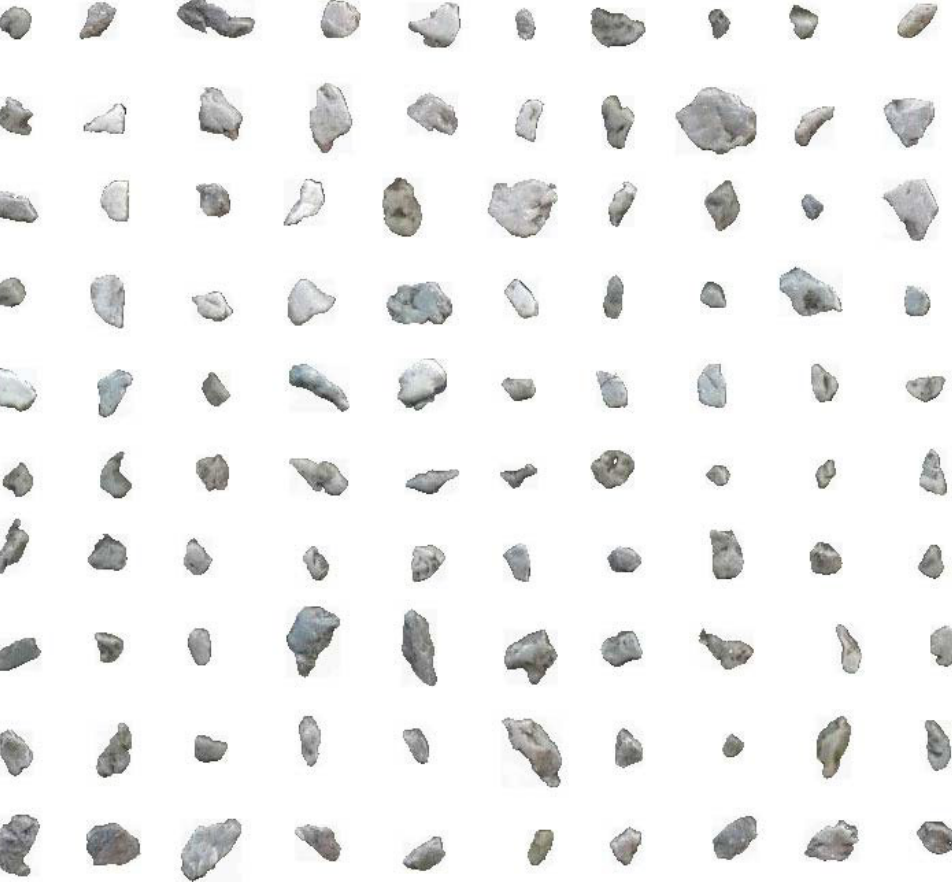
Figure 10. A total of 100 examples of a total of 1311 single-grain images segmented from the modified image of Figure 9b. Table 3. The statistical results of morphologic parameters of 20 grains (the first 10 grains and the last 10 grains shown in Figure 10).